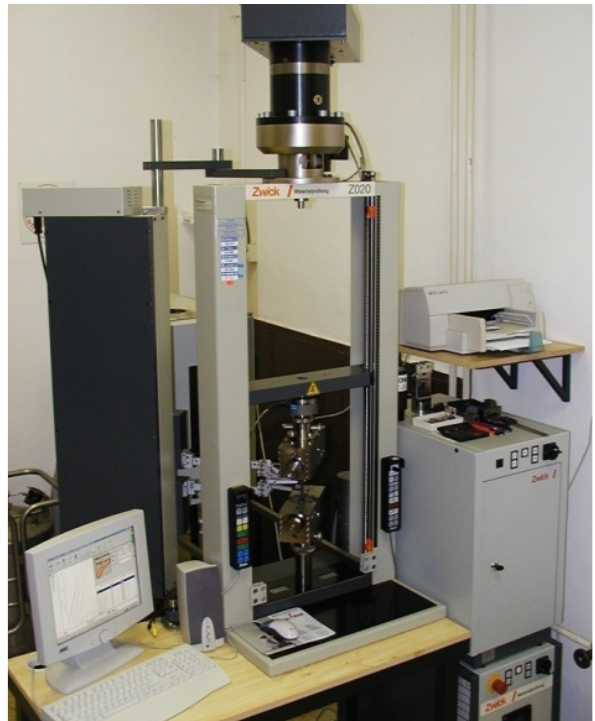
Fig. 4. ZWICK Z 020-TND testing machine.